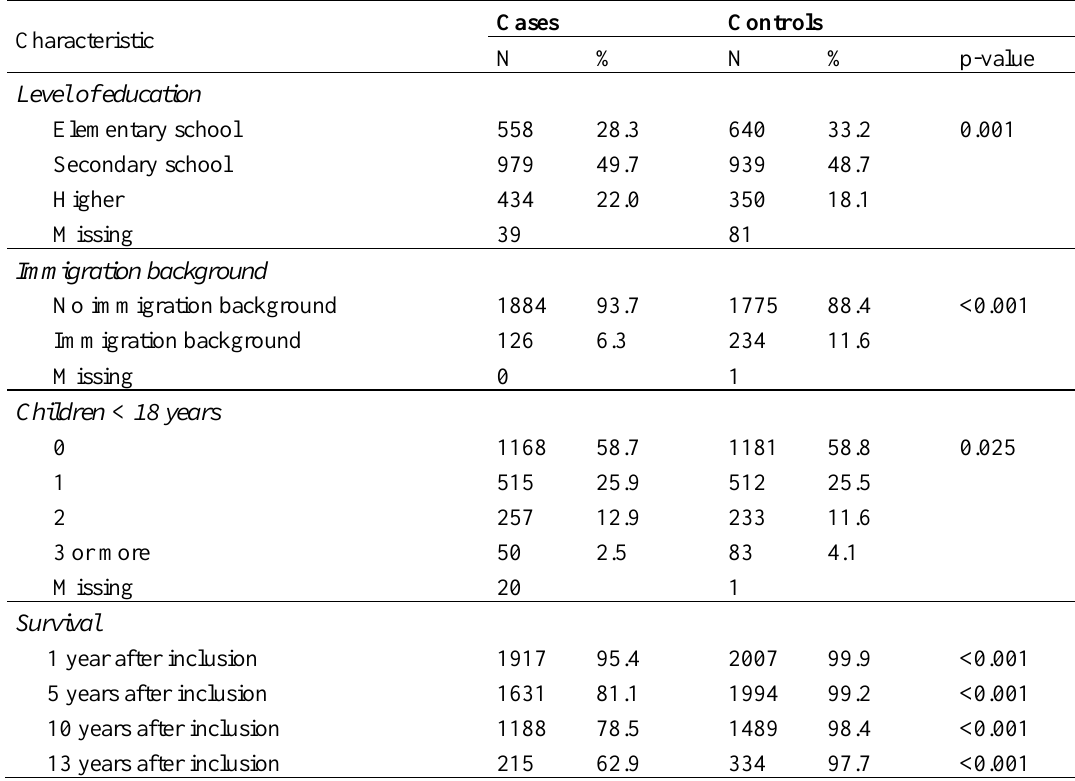
Socio-demographic characteristics of women with breast cancer and matched